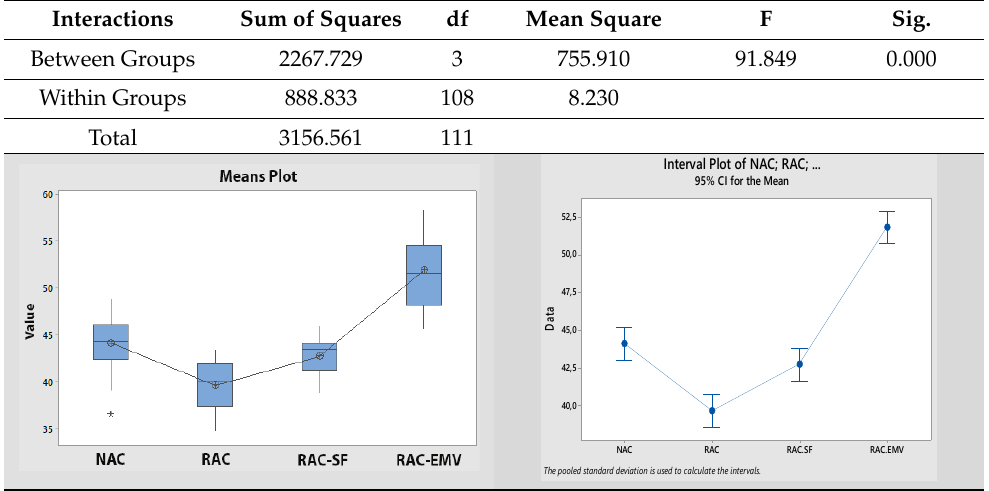
Table 9. ANOVA results with means and interval plots for concretes.